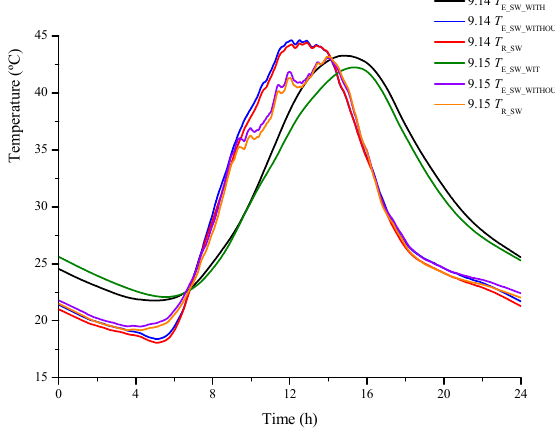
Figure 8. Temperature comparison diagram of south-facing wall.